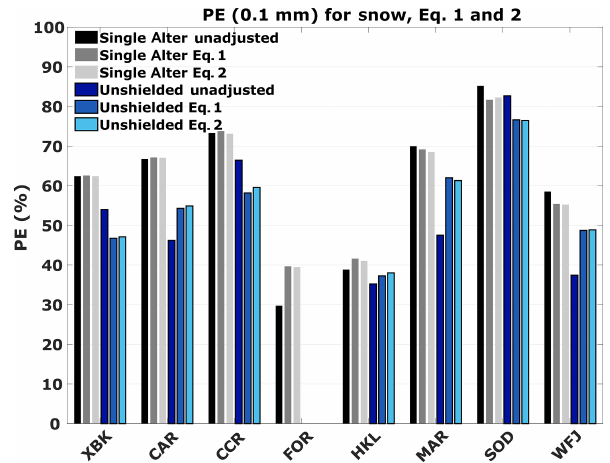
Figure 8. Percentage of events (PEs) that differ from the DFAR by less than 0.1mm for single Alter and unshielded gauges for un- adjusted measurements and for adjustments using Eqs. (1) and (2) at each of the eight SPICE sites, combining 2015/2016 and 2016/2017 winter